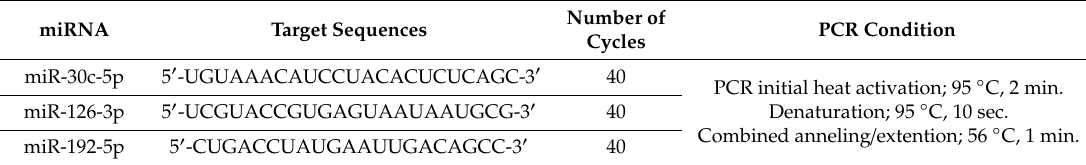
Table 1. Quantitative PCR condition for amplification of the specific